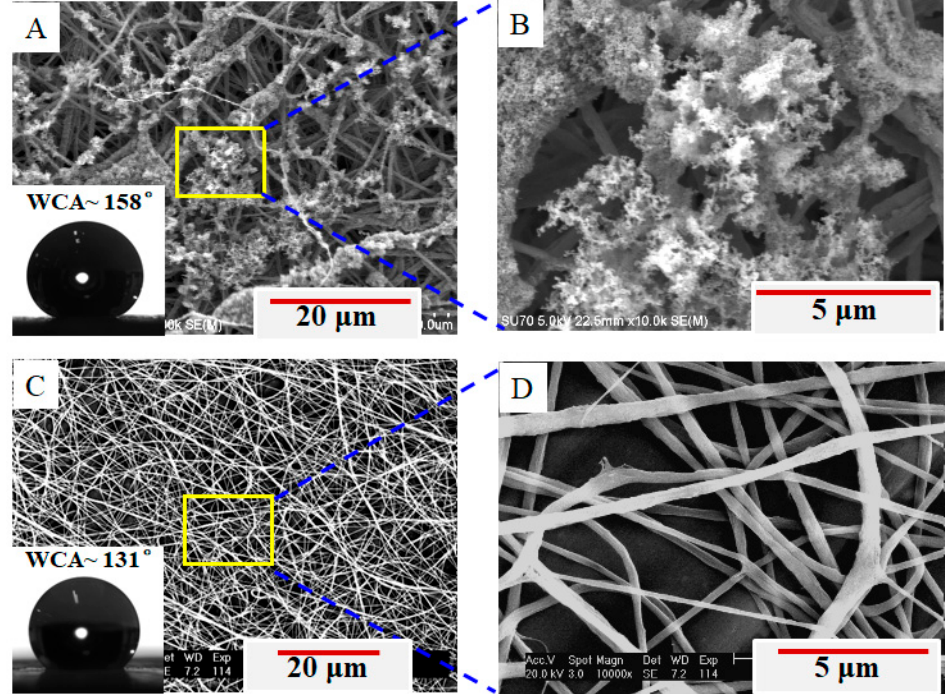
Figure 2. SEM images and water contact angle (WCA) (inset) of the electrospun fibrous membrane for different sides: ( A ) the back side showing the electrospun membrane with soot on the surface fibers and thus becoming superhydrophobic (WCA~158°, inset), and enlarged SEM image ( B ) of fibers as indicated in subfigure (A). ( C ) The front side showing the electrospun membrane with no soot on fibers and only presenting as hydrophobic (WCA~131°, inset), and enlarged SEM image ( D ) of fibers as indicated in (C) .